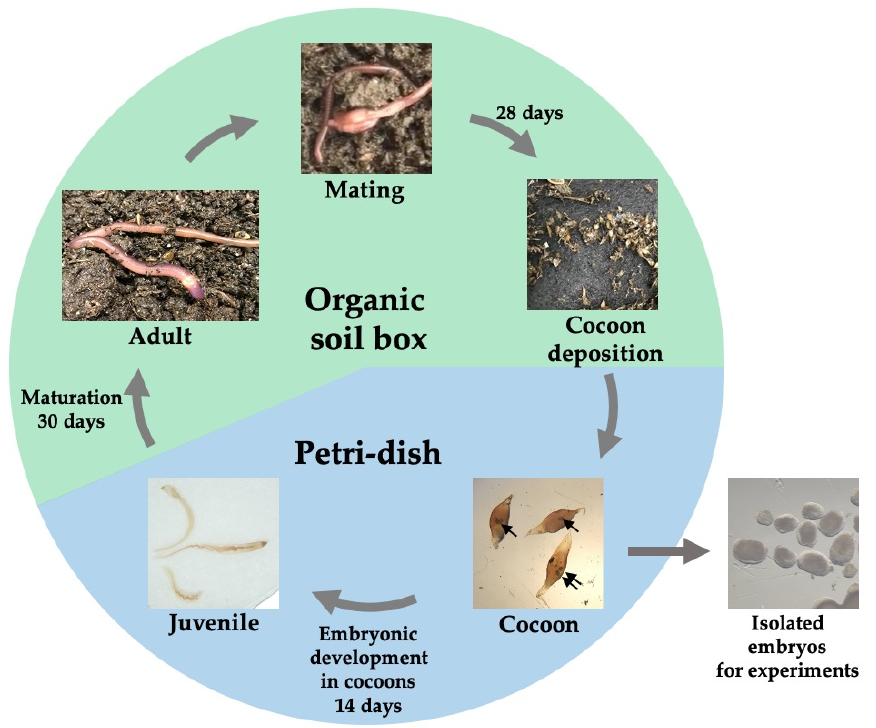
Figure 1. The life cycle of P. excavatus. Arrows indicate embryos in